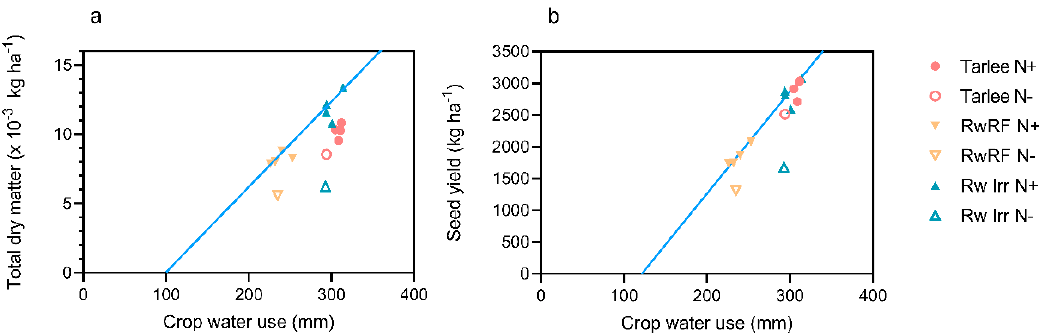
N . Rate N . Time N . (Rate × Time) * The N trial was designed as a nil control plus a factorial combination of N rate and N timing. The N e ff ect tests the nil N treatment vs. the application of N across all rates and times of N application, while the main e ff ect of the rate of N is indicated by N . Rate and the main e ff ect of time of N application by N . Time. The interaction between N rate and timing among the treatments that received N is shown as N . (Rate × Time).